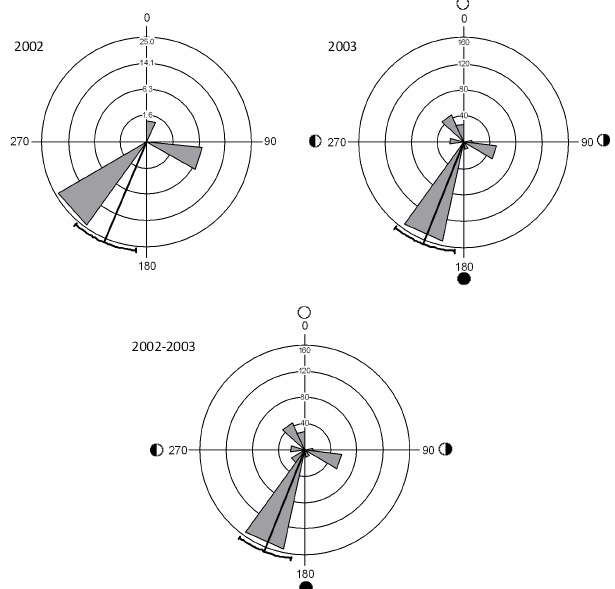
Figure 3. Patterns of reproductive phenology in Rana dalmatina in relation to lunar cycle at the study locality in Mediterranean Cen- tral Italy. Datasets from 2001, 2001 with cloud cover information (2001 ∗ ), 2003 and pooled years (2001–2003) are shown. Area of wedges represents the number of egg clutches (each one considered a proxy of a single pair in spawning activity) laid during a single night. Concentric dotted lines represent the scale for the number of egg masses (numbers only on the top axis). Black ray indicates the mean vector ( µ ) and the external black curved line represents 95% confident intervals (in grey if the statistic was unreliable). 0 ◦ = full moon; 180 ◦ = new